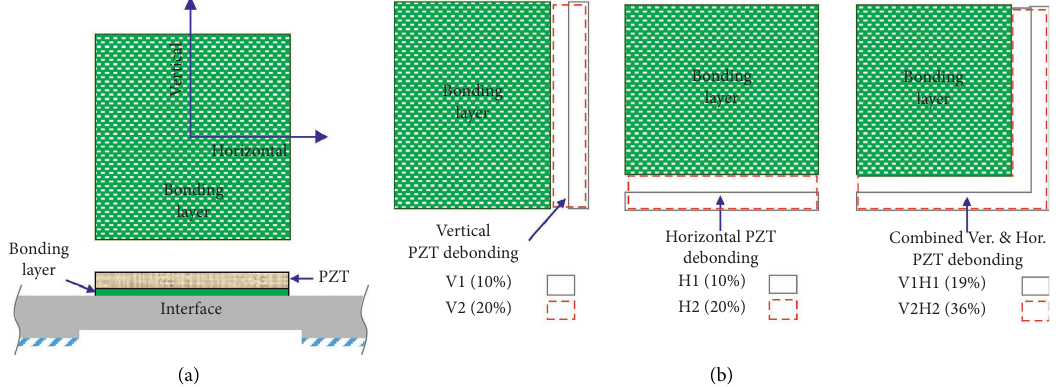
Figure 17: Simulation of PZT debonding cases for the smart interface. (a) Intact. (b) Debonding cases: V1, V2, H1, H2, V1H1, V2H2.